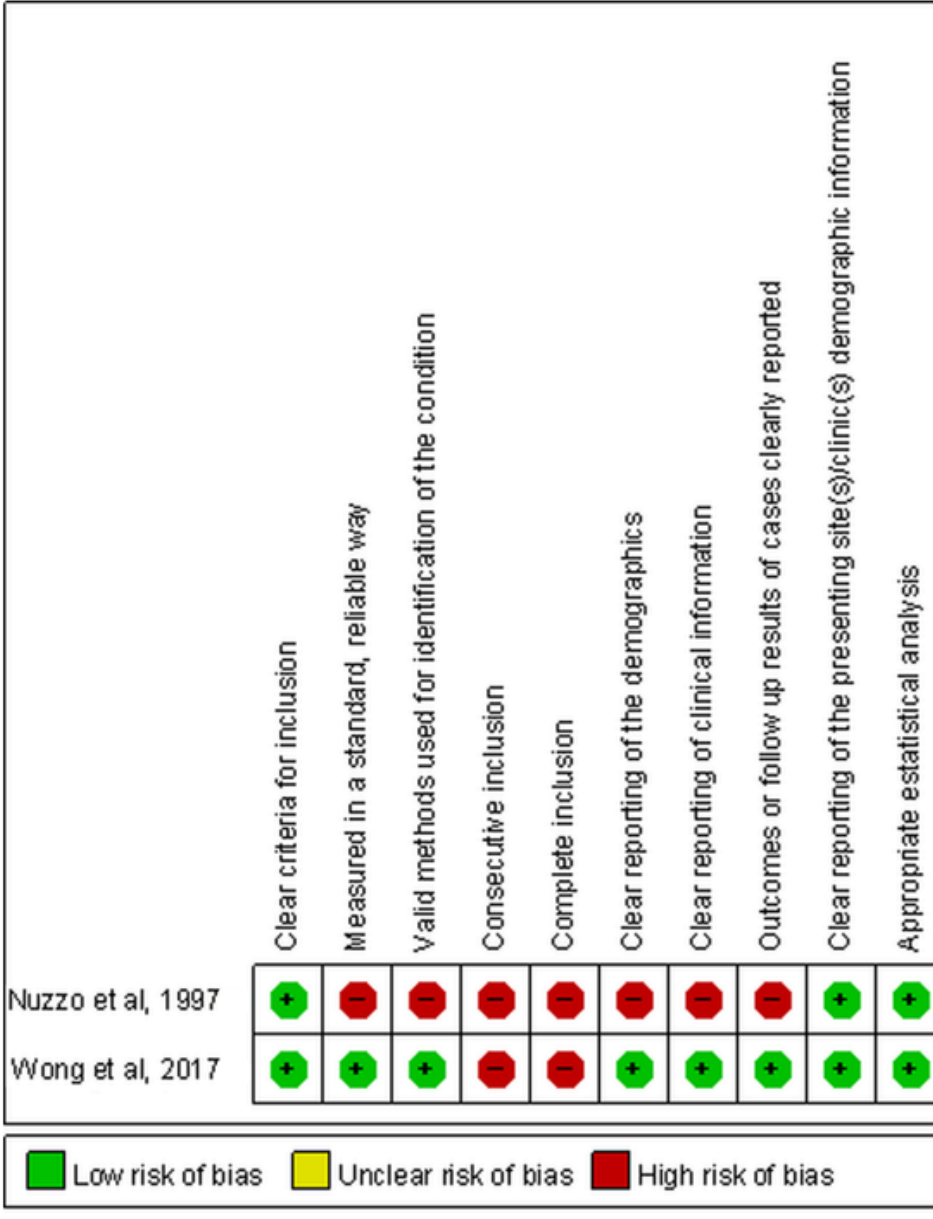
Figure 3. Summary for risk of bias of nonrandomized controlled studies.